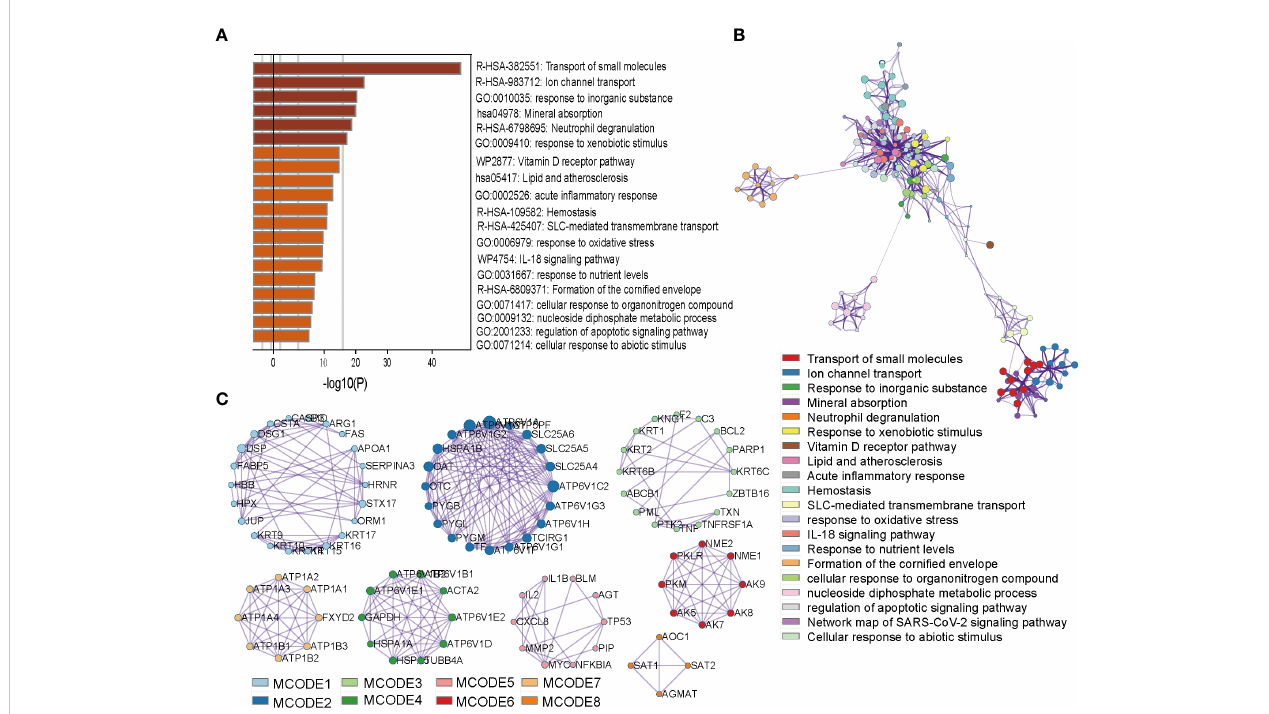
FIGURE 5 Enrichment and interact network of prognostic OM genes participating. (A) Bar graph of terms enriched across prognostic OM genes and their interacting genes. (B) Network of enriched terms colored by cluster ID, where nodes that share the same cluster ID are typically close to each other. (C) , Densely connected network components identi fi ed by the Molecular Complex Detection (MCODE)